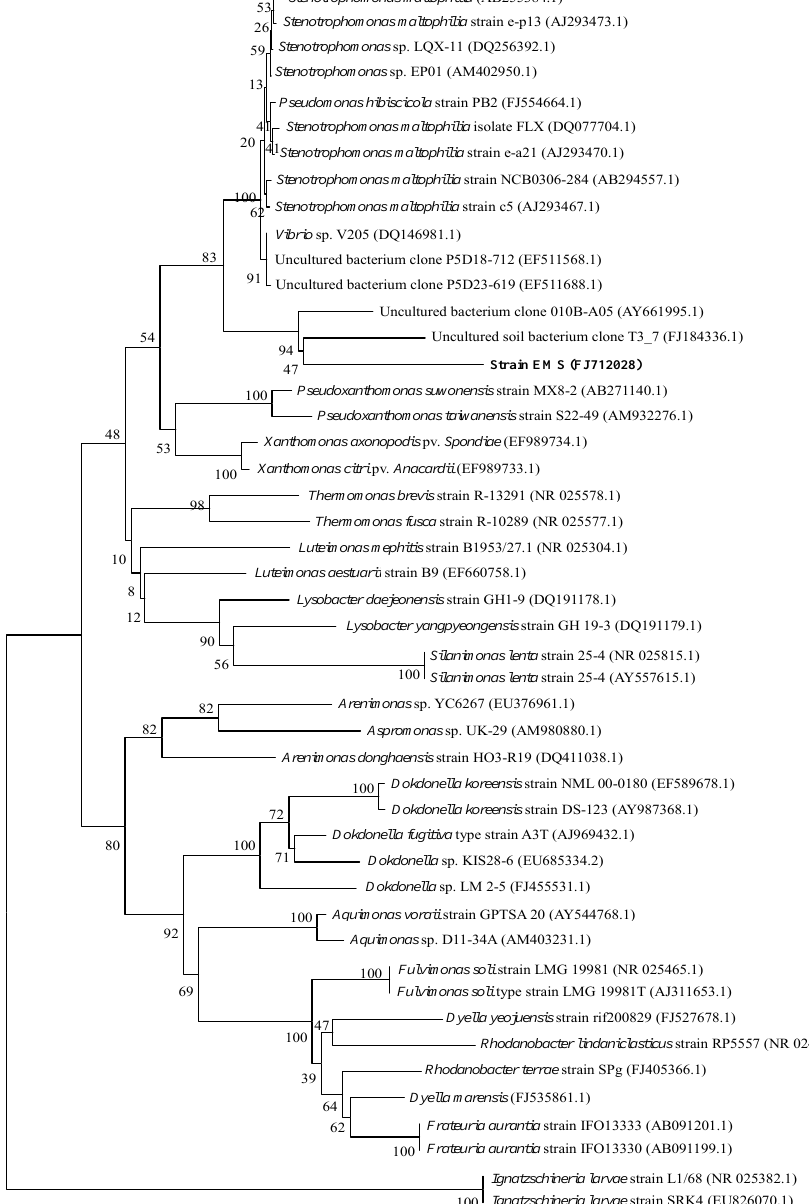
Figure 2. Phylogenetic tree indicating the position of strain EMS in the established related species of the genus. The value on each branch is the estimated confidence limit (expressed as a percentage) for the position of the branch as determined by a bootstrap